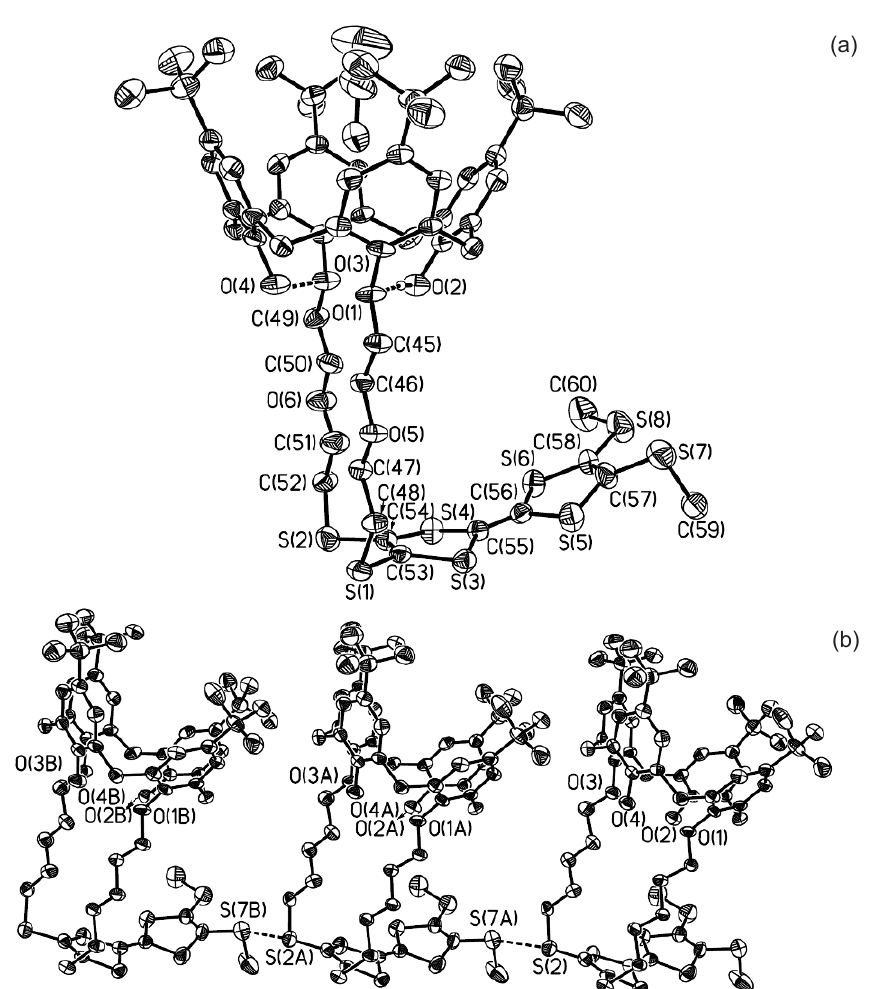
Figure 1. (a) Molecular structure of 5 (All hydrogen atoms and disordered carbon atoms of tert-butyl groups are deleted for clarity); (b) 1D chain formed by weak S ⋅⋅⋅ S interactions along b